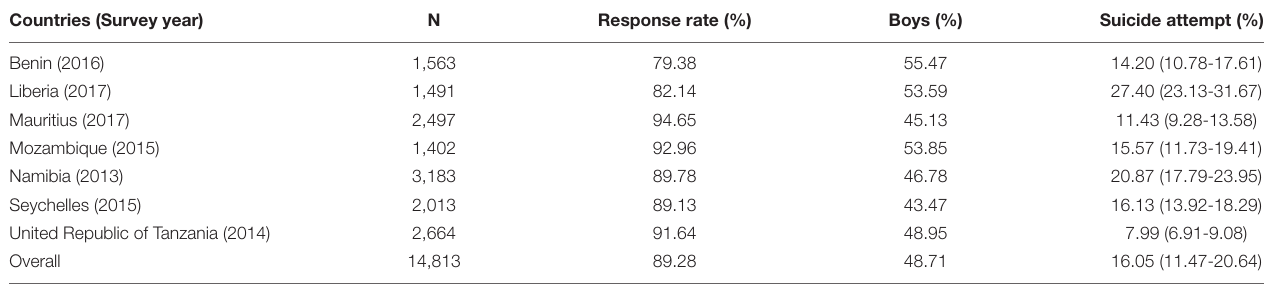
TABLE 1 | Survey characteristics by country among in-school African adolescent. Countries (Survey year)